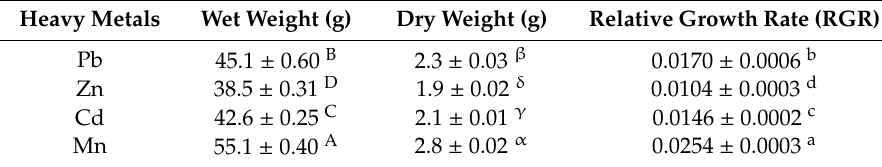
Table 6. Growth of Eichhornia crassipes plants in karst water with Pb, Zn, Cd, and